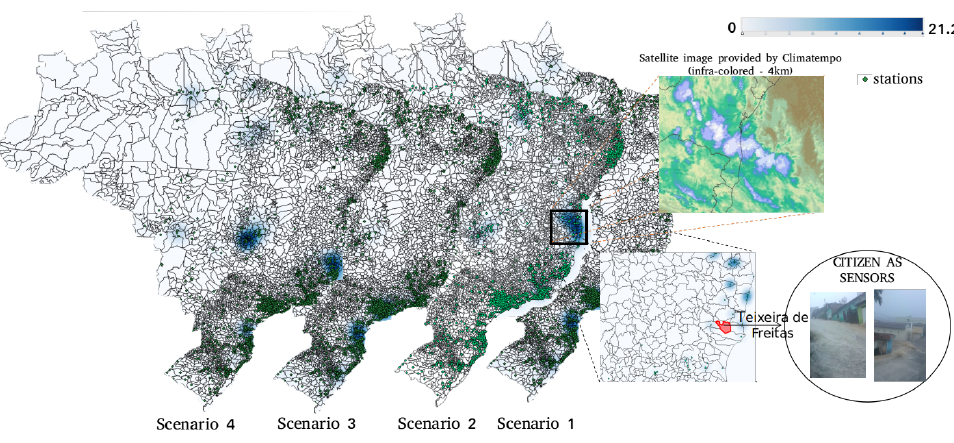
Figure 25. Brazilian scenarios of flash